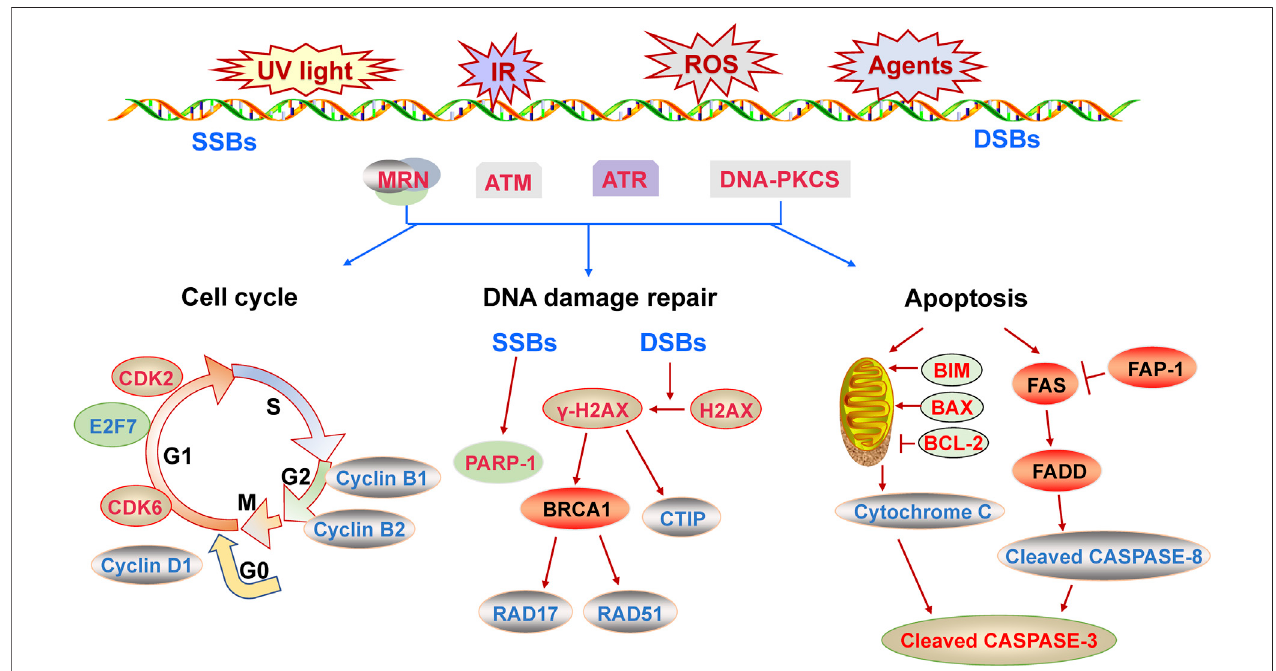
FIGURE 1 | The molecular mechanism of DNA damage response described from three aspects of cell cycle, DNA repair and